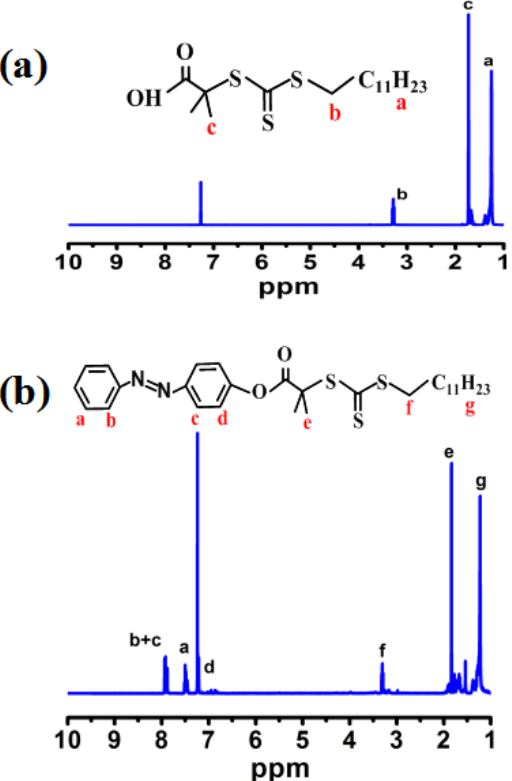
Figure 3. 1 H NMR spectra of RAFT ( a ) and azobenzene-RAFT ( b ).